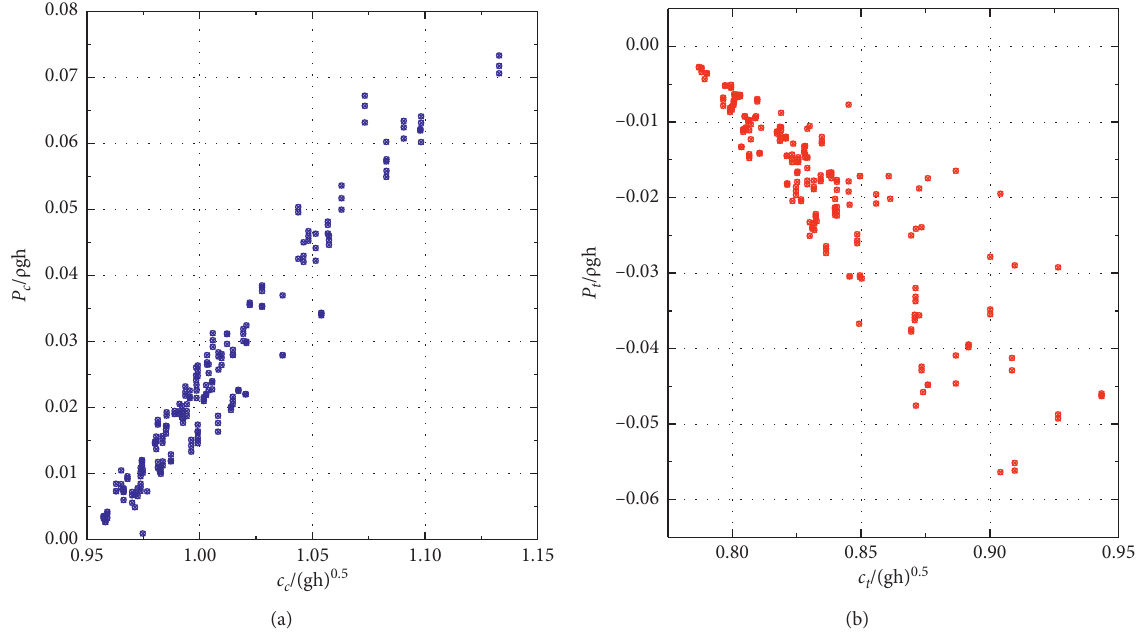
Figure 13: The relative dynamic pressure and the relative wave propagation